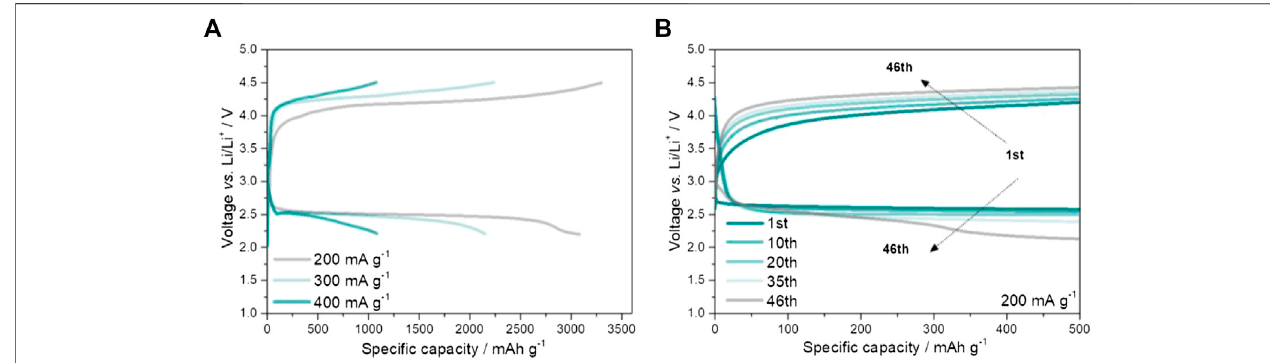
FIGURE 3 | Galvanostatic discharge/charge pro fi les of NiFeRu-LDH@GF electrodes (A) at different current densities and (B) different cycles.